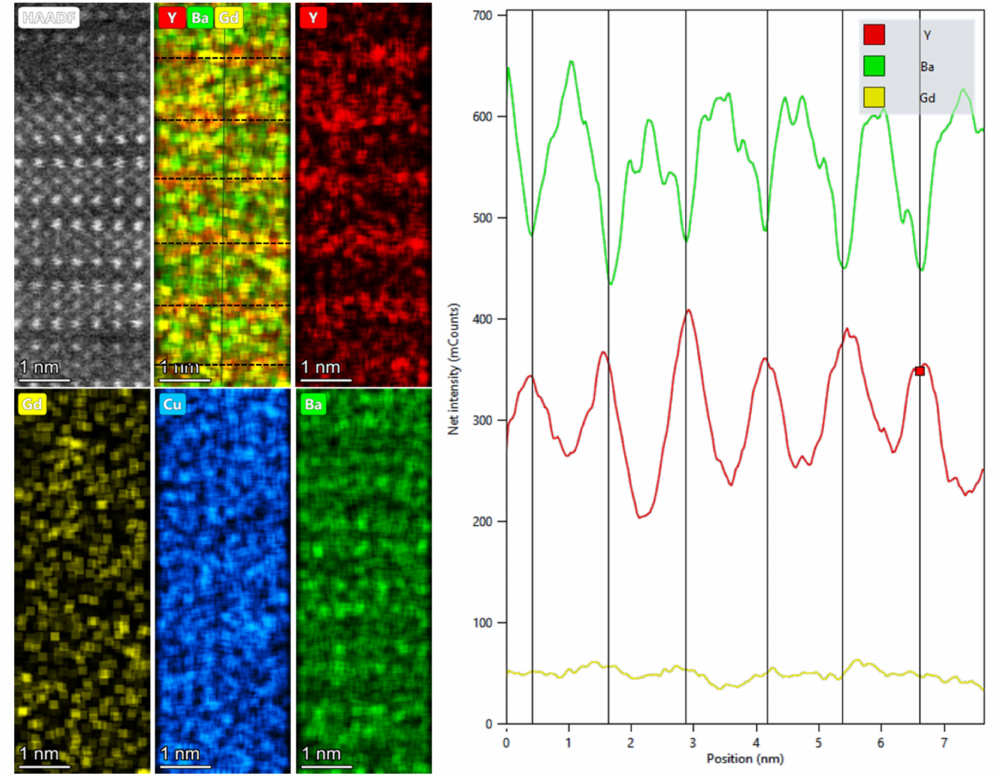
Figure 7. High-resolution HAADF STEM together with corresponding elemental Y, Gd, Ba, and Cu EDX maps and the profile over the image (starting from the bottom to the top) of YBCO-Gd 5% film deposited by the standard process. The Y / Gd planes positions are marked by black vertical continuous (profile plot) and horizontal dashed (map image)